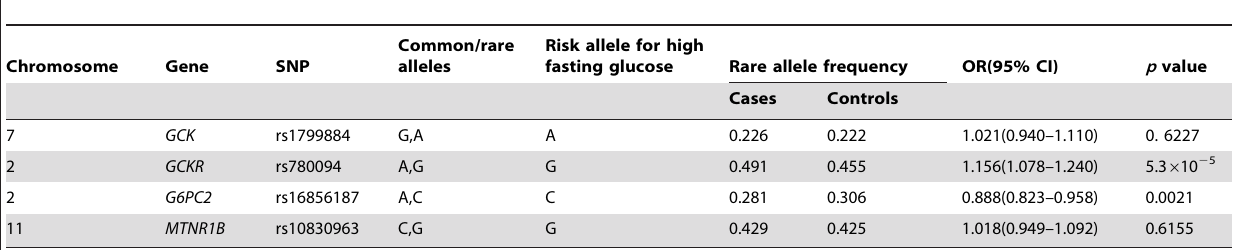
Table 3. Association between GCK , GCKR , G6PC2 and MTNR1B variants and type 2 diabetes in the Chinese population.